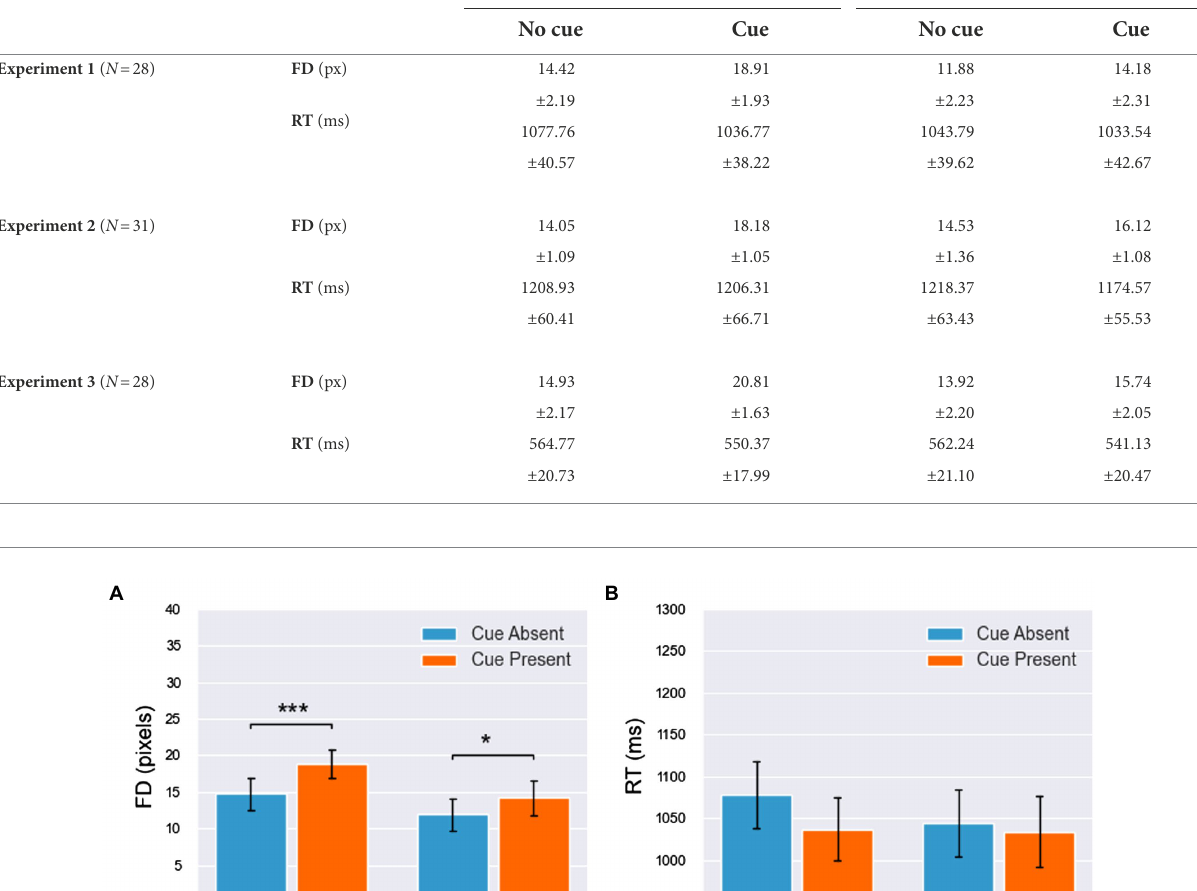
TABLE 1 The means and standard errors in all three experiments.